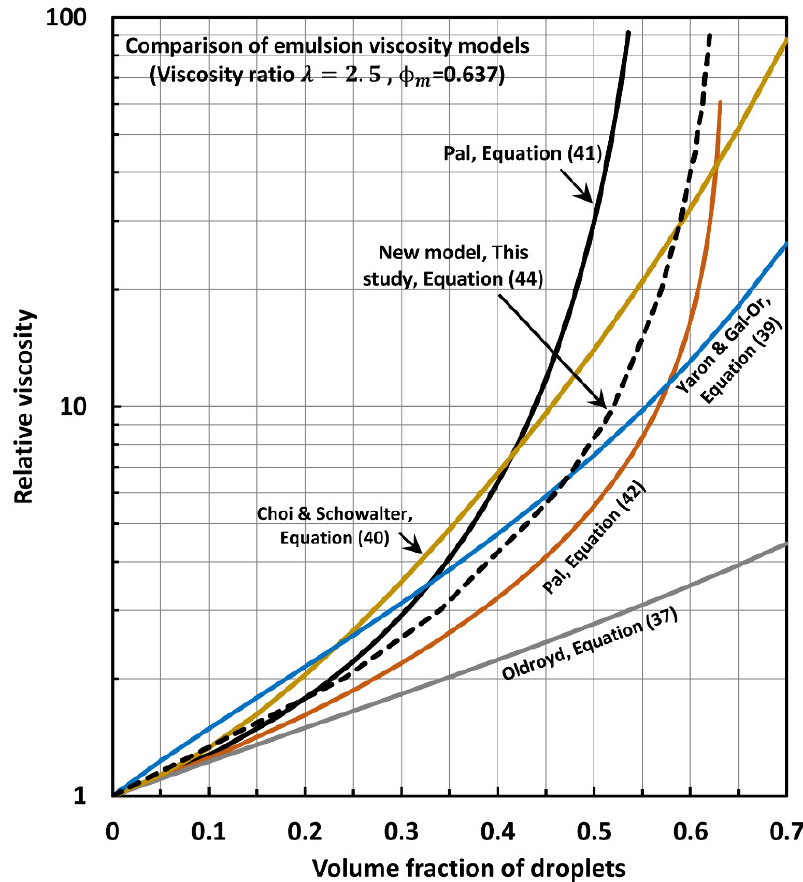
Figure 19. Comparison of various emulsion viscosity models (viscosity ratio λ = 2.5 and φ m = 0.637 ).